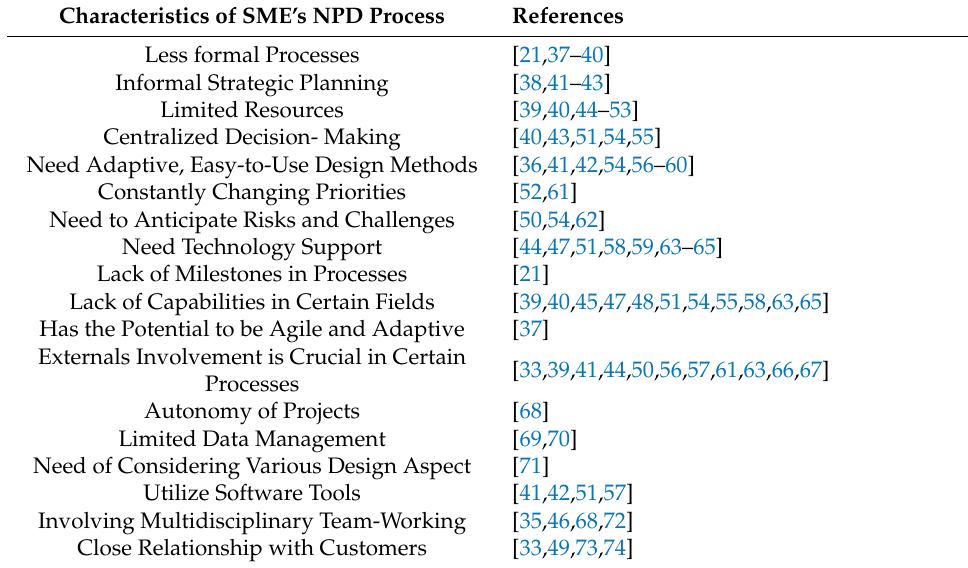
Table 6. Characteristics of SMEs’ NPD